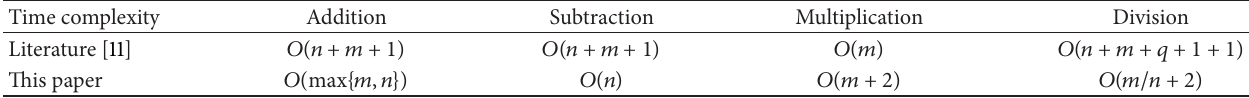
Table 4: Comparison of time complexity of two methods.